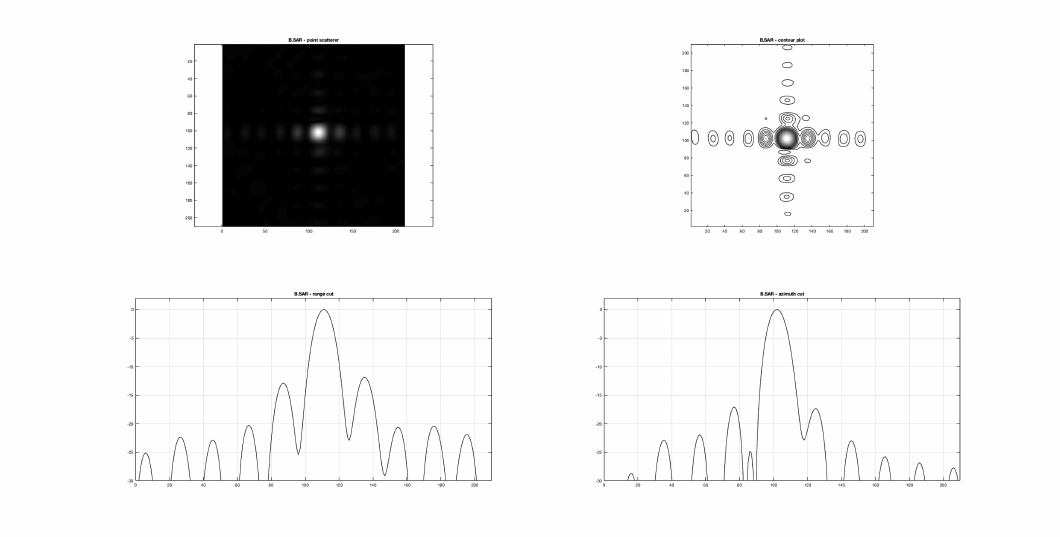
Figure 10. B-SAR algorithm. Point scatterer image, contour plot, and range and azimuth